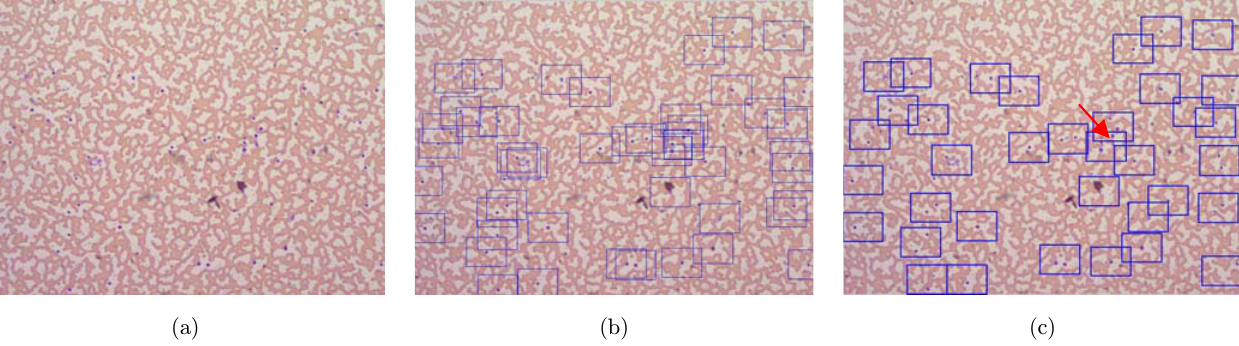
Fig. 5. Scanning routine design. (a) One of the captured low power microscopic image while scanning, (b) scanning routine composed of leukocyte nucleus' centroids and (c) Scanning routine composed of max – min distance clustering centers.